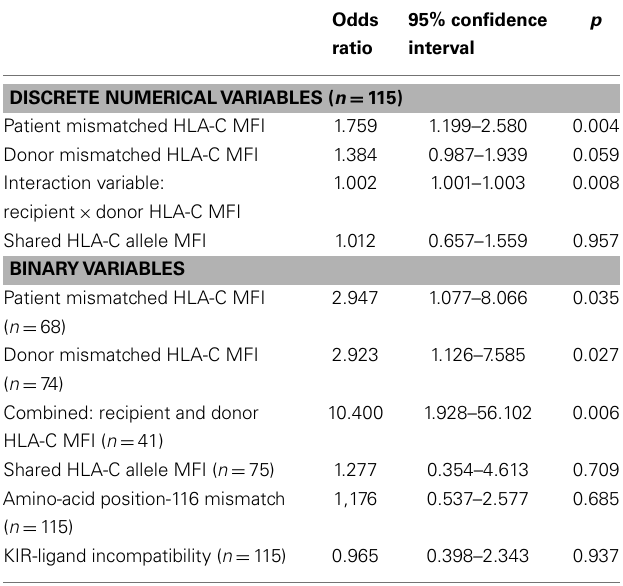
Table 1 | Univariate logistic regression analysis for prediction of CTLp outcome .